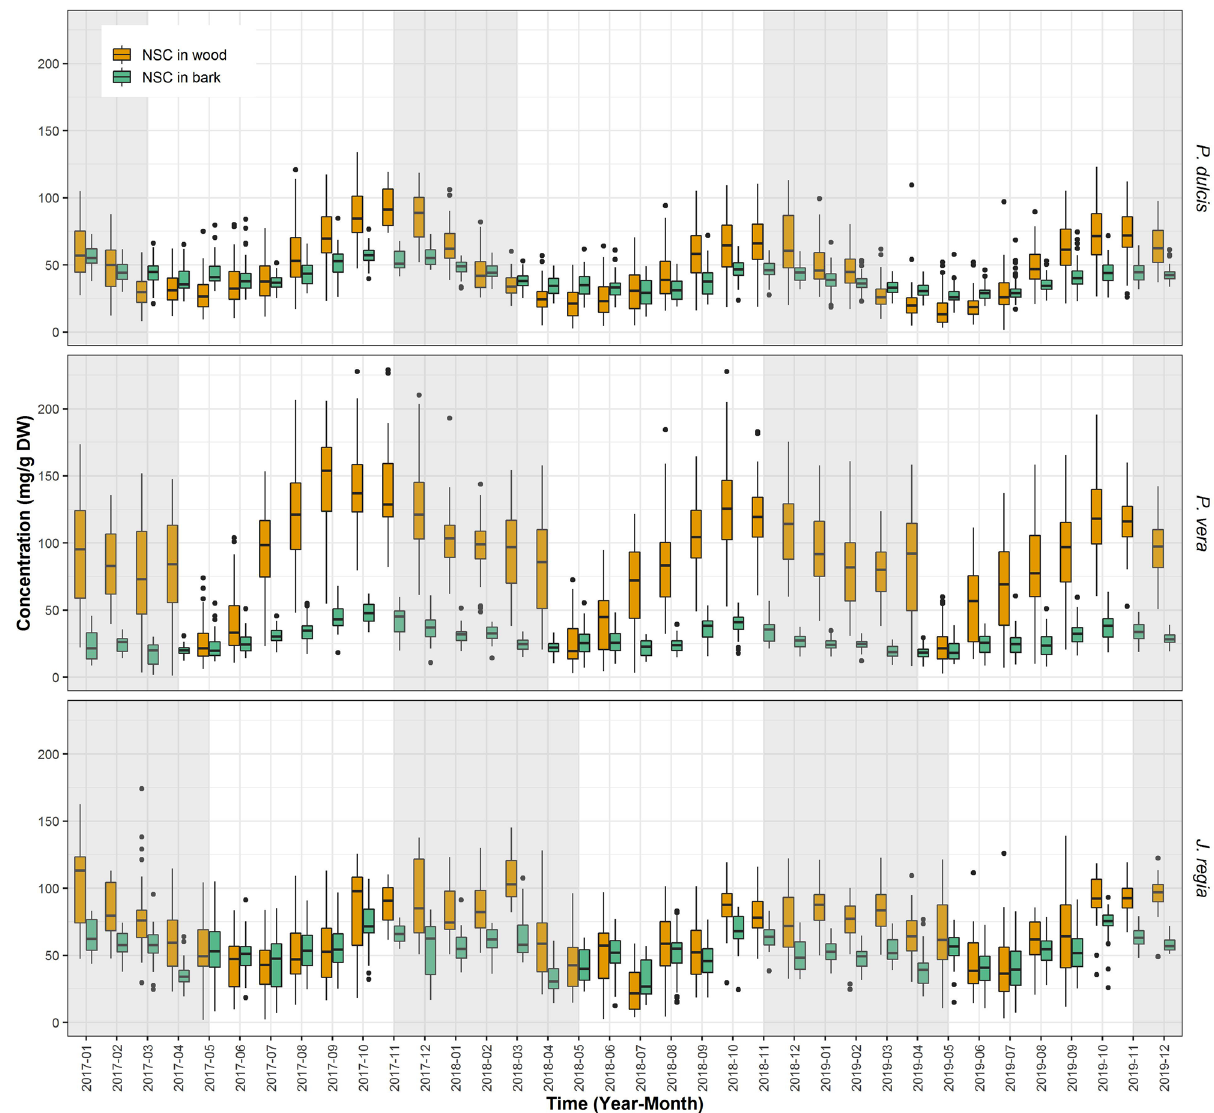
Figure 3. Total NSC concentration in wood and bark in three species. Average concentration of total NSC (Sc + ST) in wood (orange) and in bark (green) from all sites for P. dulcis , P. vera and J. regia from January 2017 to December 2019. The upper whisker extends from the hinge to the largest value no further than 1.5*IQR from the hinge (where IQR is the inter-quartile range, or distance between the first and third quartiles). The lower whisker extends from the hinge to the smallest value at most 1.5*IQR of the hinge. Grey shading reflects the dormancy period of each